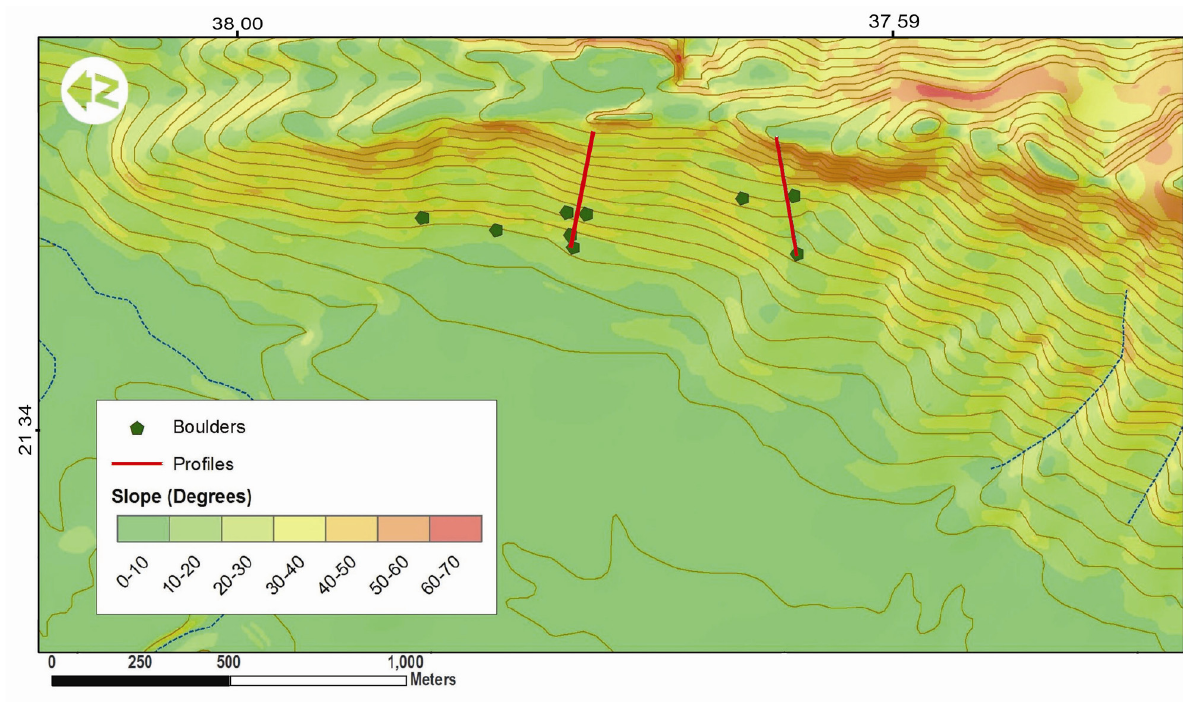
Figure 14. Slope map of the study area showing the location of boulders and the profiles used for evaluating the rock-fall hazard in this study (contour lines: 20